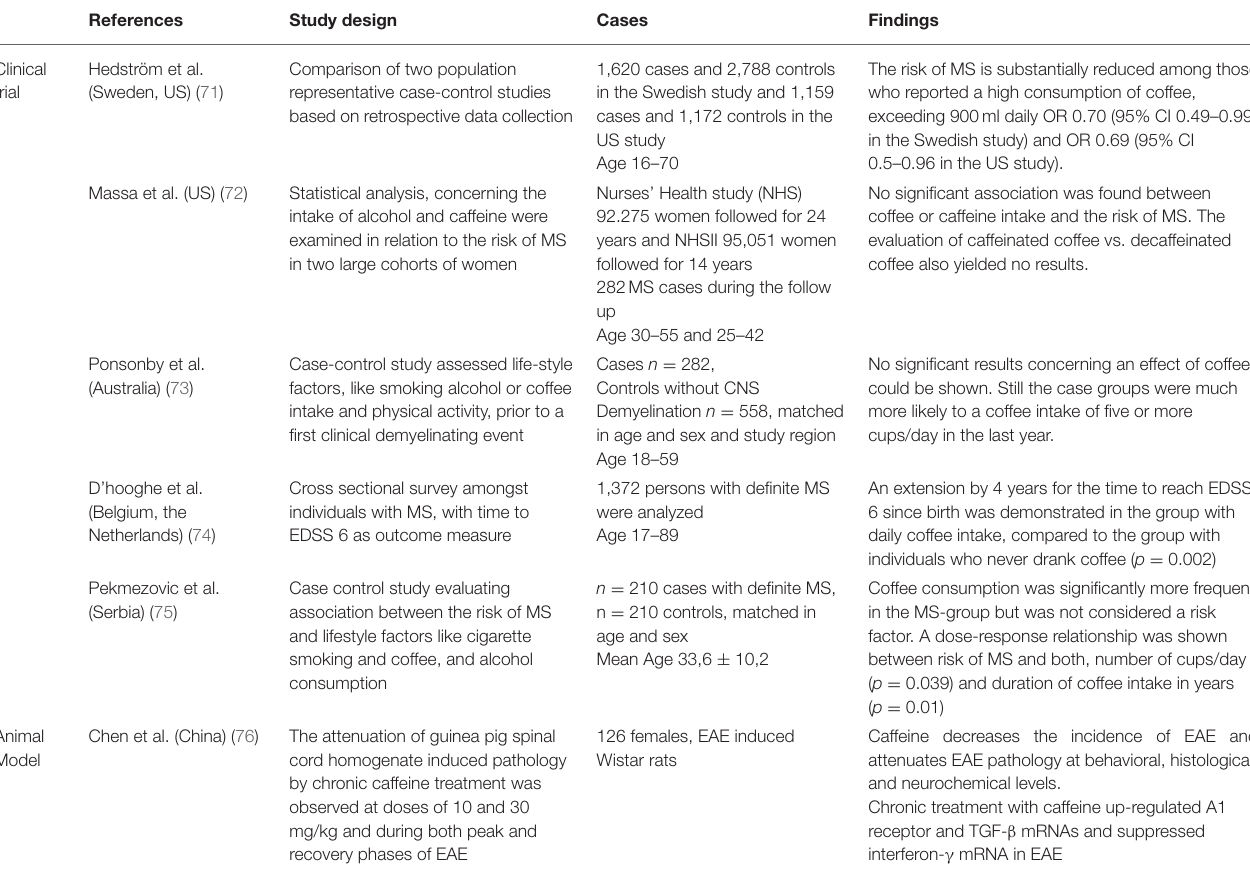
TABLE 3 | Studies evaluating the effect of coffee on multiple Sclerosis and